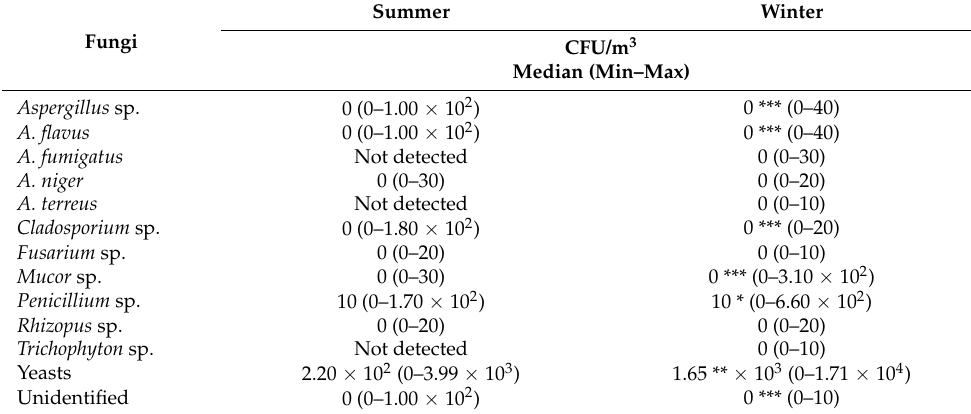
Table 6. Composition of tracheal fungal flora during five-week broiler fattening in summer and winter.